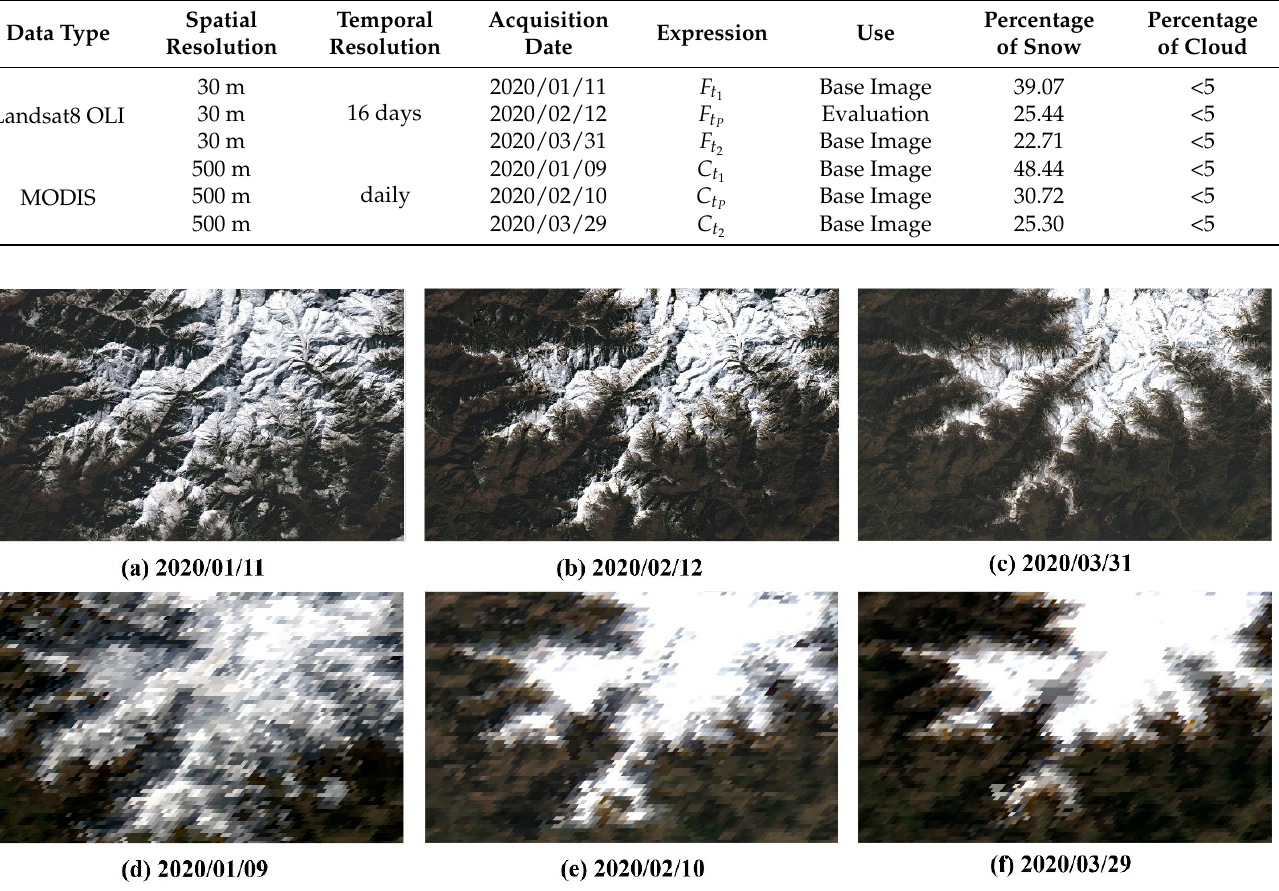
Figure 2. The RGB composites of MODIS and Landsat surface reflectance. ( a – c ) are Landsat surface reflectance images on 2020/01/11, 2020/02/12, and 2020/03/31, and the percentage of snow cover is 39.07%, 25.44%, and 22.71%. ( d – f ) are MODIS surface reflectance images on 2020/01/09, 2020/02/10, and 2020/03/29, and the percentage of snow cover is 48.44%, 30.72%, and 25.30%, respectively.